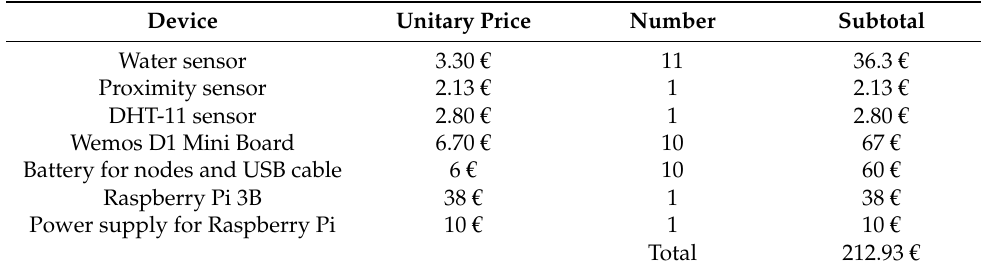
Table 5. Budget for a deployment in a